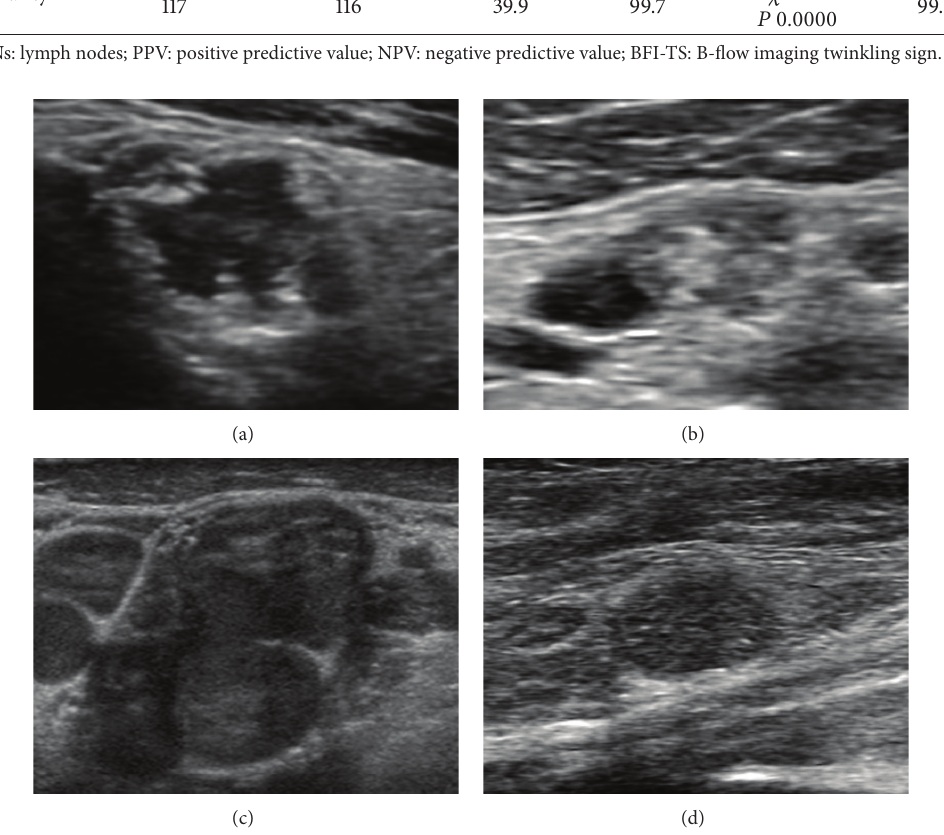
Figure 1: Metastatic lymph nodes at grayscale examination in patients with papillary thyroid cancer. Absence of echogenic hilum ((a), (b), (c), (d)), abnormal echogenicity ((a), (b), (c)), calcifications (b), cystic change ((a), (b)), and round shape ((c),